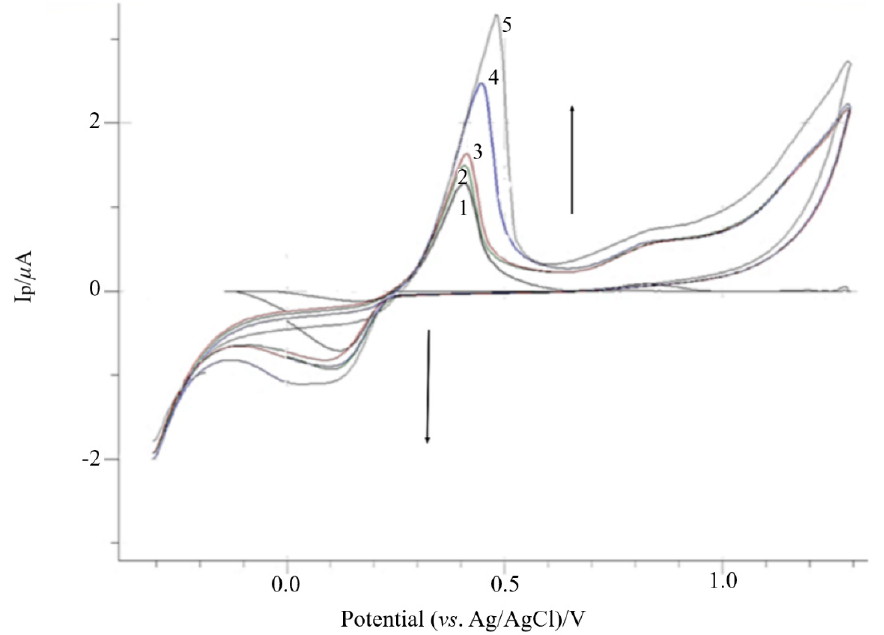
Figure 2. Electrochemical deposition of AgNPs@Sa (428.6 mg L − 1 ) in phosphate buffer pH 7.0 containing 0.03 mol L − 1 NaNO 3 at 30 mV s − 1 on CPE. (1) Scan 1, (2) scan 2, (3) scan 3, (4) scan 4, (5) scan 5. Other experimental conditions as mentioned in the Materials and Methods section.